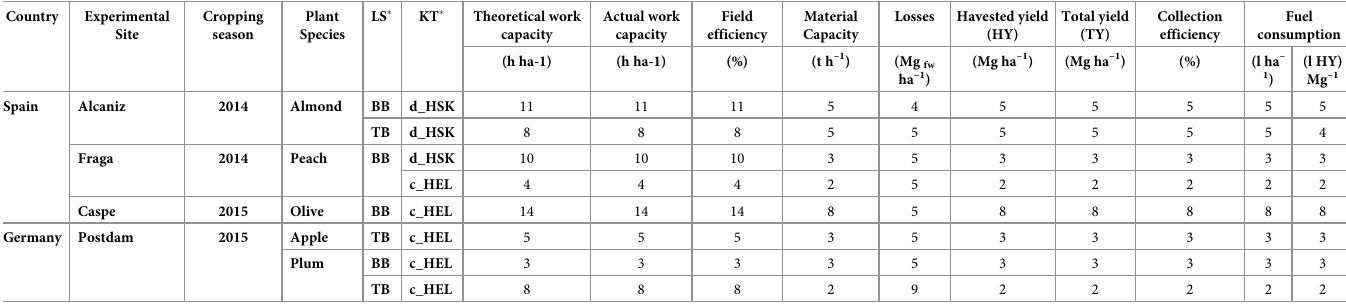
Table 2. Variables related to the machine performances, number of replicate per treatment: Loading system [LS] and Knife type [KT]. Country Experimental